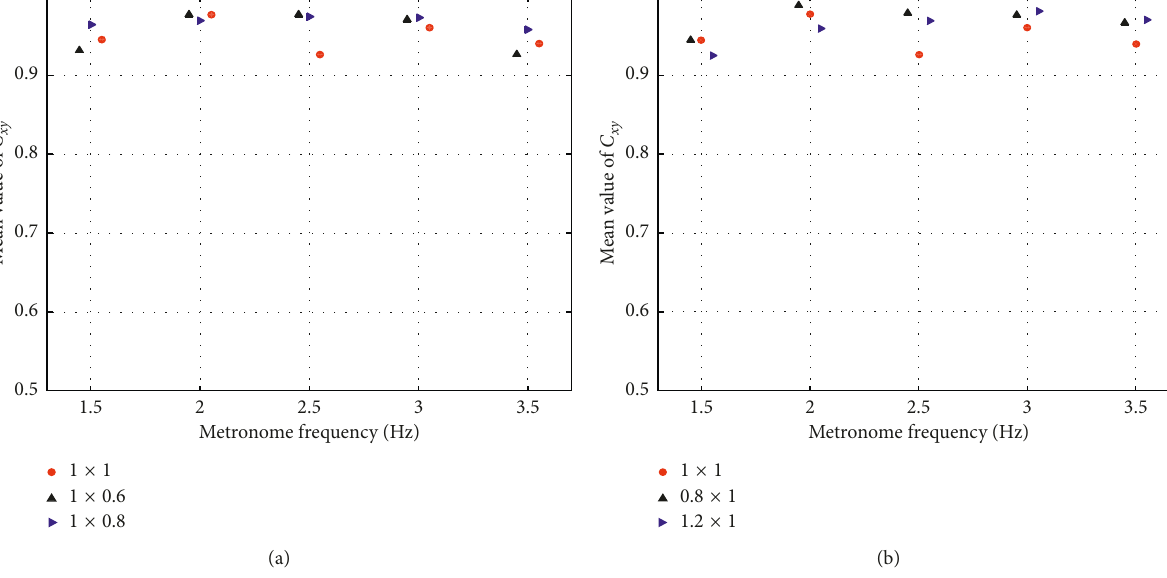
Figure 31: Comparison of the mean values of coherence coefficients with double distances in two groups. (a) Group 01; (b) group